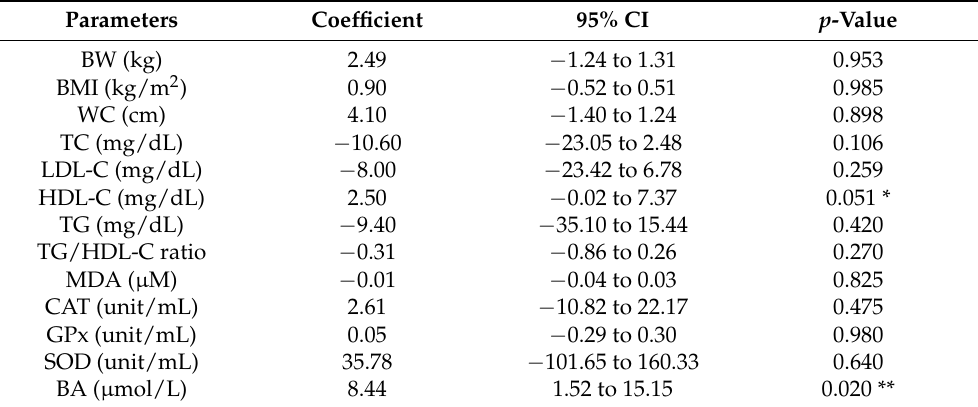
Table 5. Gaussian regression analysis of physical examination parameters and biological markers for the probiotic group compared with the placebo group at the endpoint (Day 30) of the study.